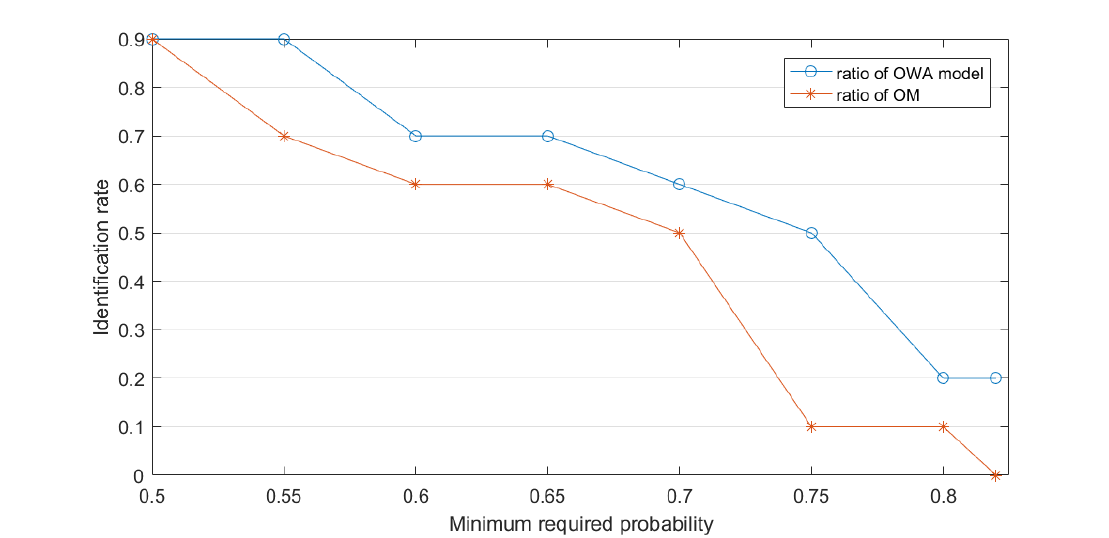
Figure 4. Identification effect in Example